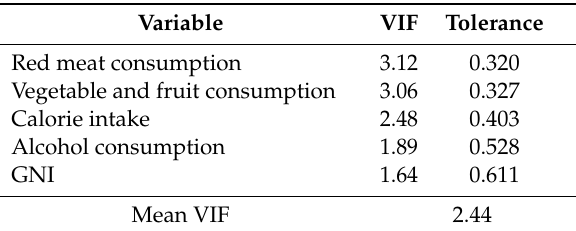
Table 1. Results of multicollinearity analysis.